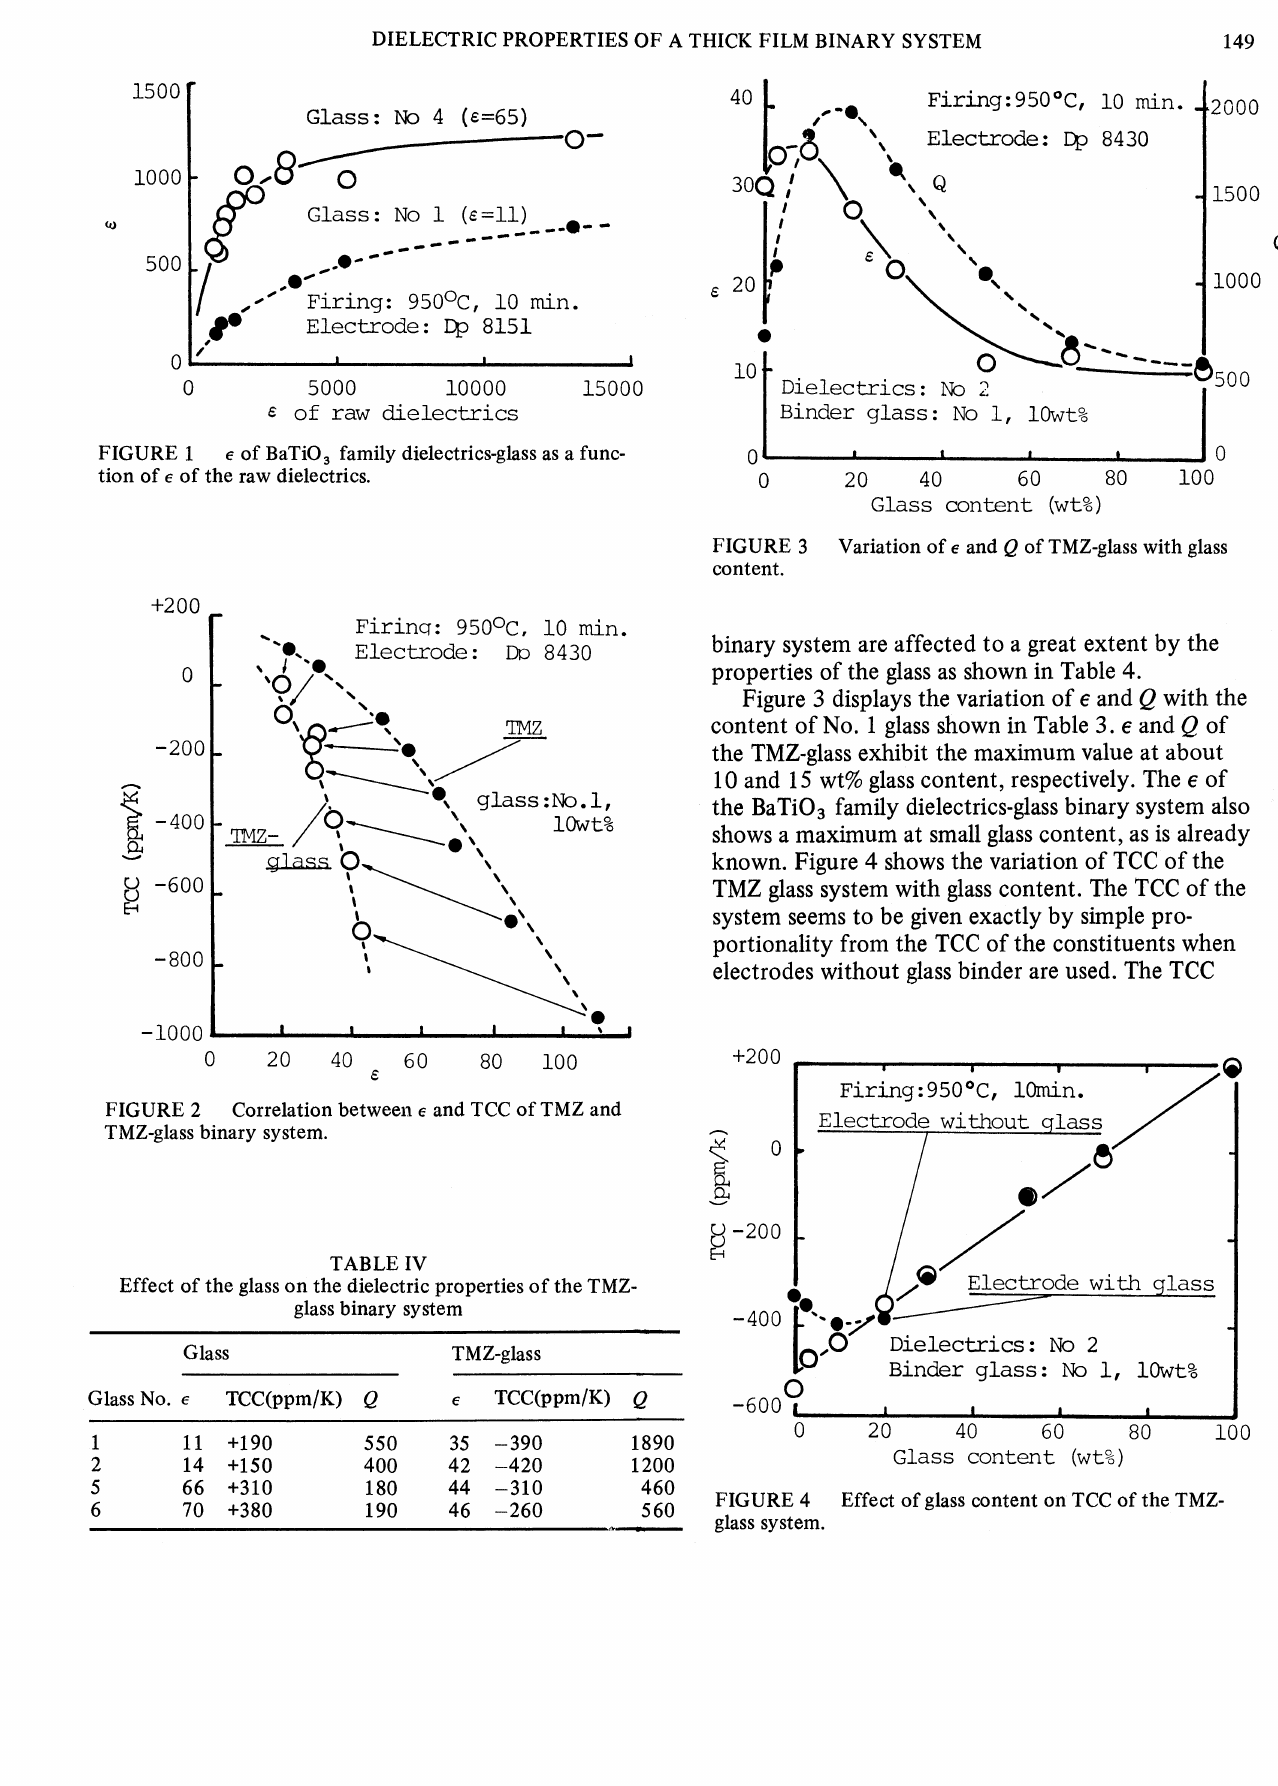
e of BaTiO family dielectrics-glass as a func- tion of e of the raw dielectrics.